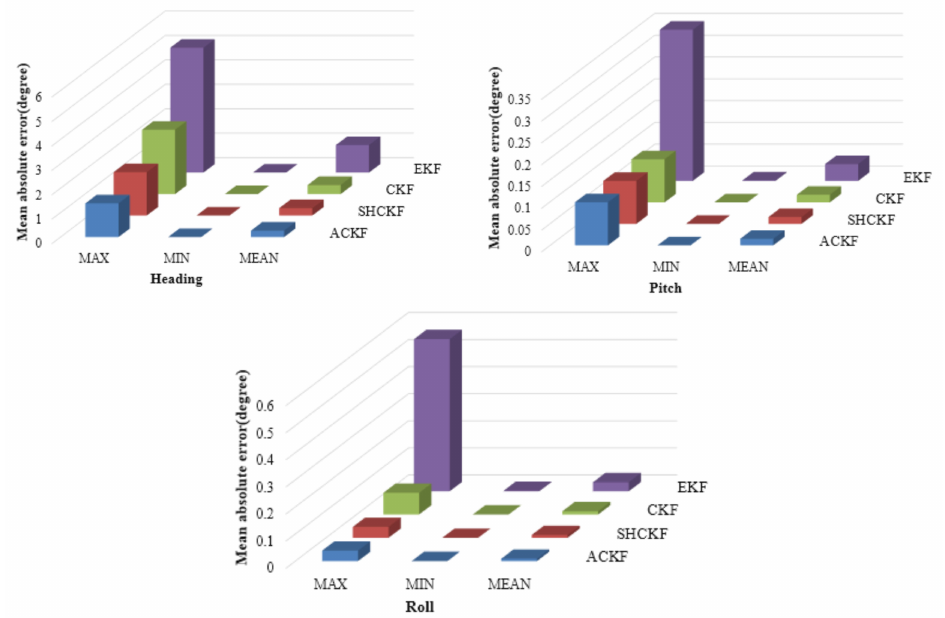
Figure 6. Distributions of mean absolute errors of extended Kalman filter (EKF), cubature Kalman filter (CKF), Sage-Husa cubature Kalman filter (SHCKF), and